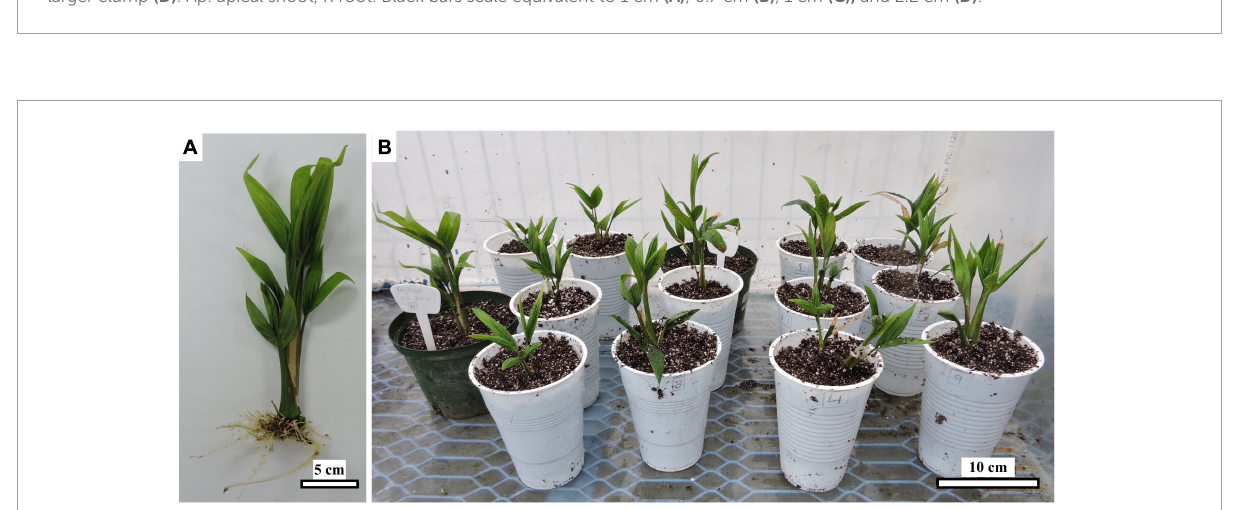
FIGURE9 Ex vitro peach palm plantlet as comes out of the in vitro phase 17 months ACI with 450 µ M picloram (A) and during acclimatization (B) . Black bars scale equivalent to 5 cm (A) and 10 cm (B)